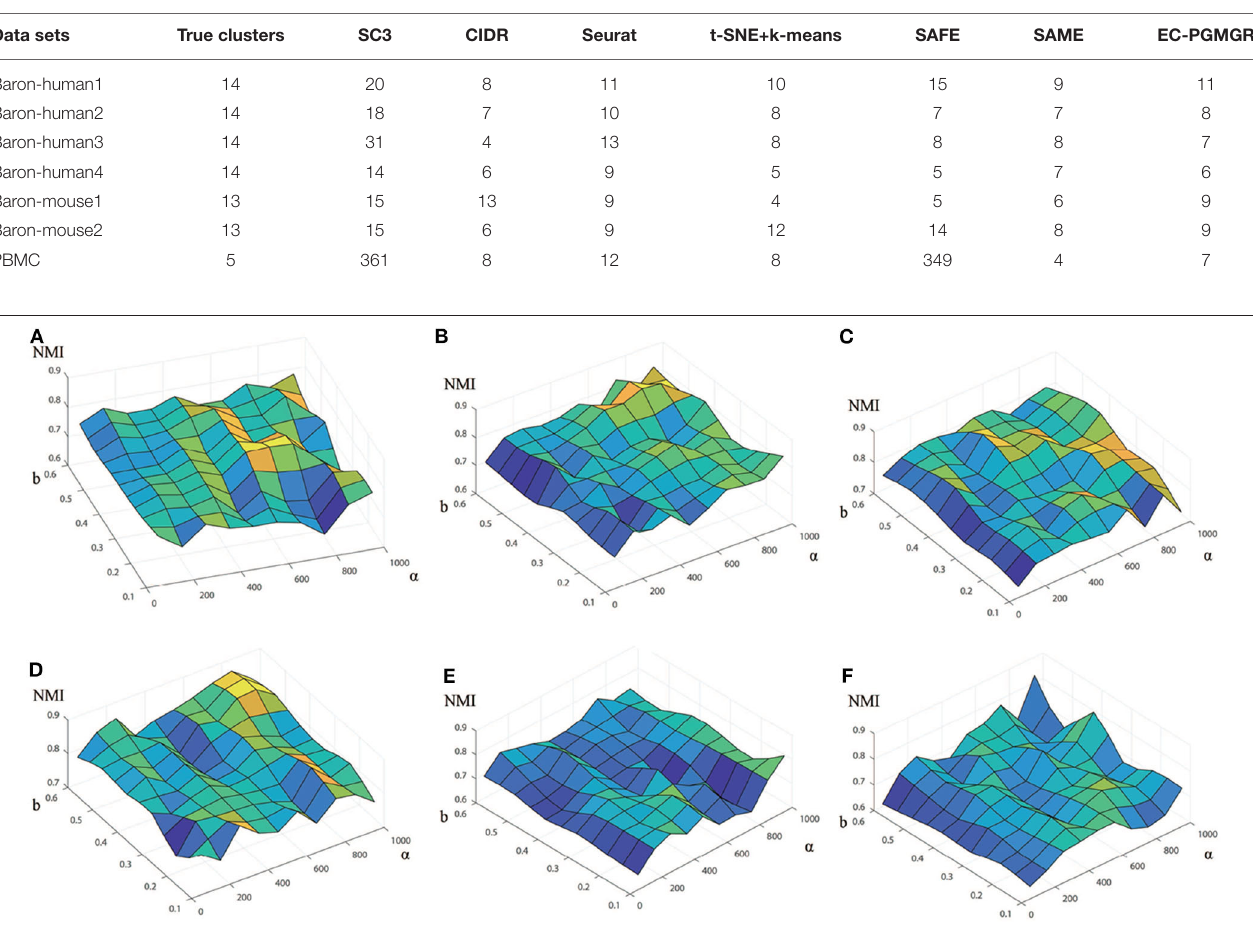
FIGURE 2 | Performance of EC-PGMGR on 6 benchmark data sets with respect to different values of b and α measured in terms of the NMI score. The x-axis denotes the value of α , the y-axis denotes the value of b , and the z-axis denotes the value of the NMI. (A) Baron-human1. (B) Baron-human2. (C) Baron-human3. (D) Baron-human4. (E) Baron-mouse1. (F)